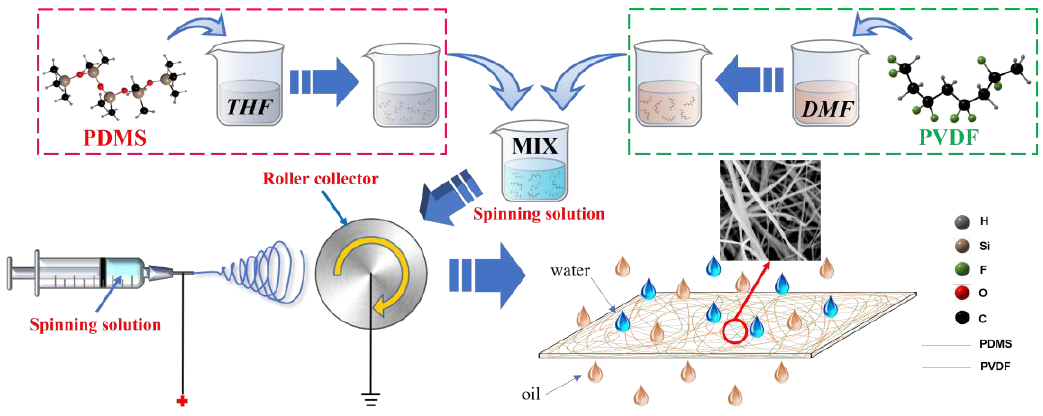
Figure 1. The preparation process of PVDF/PDMS electrospinning